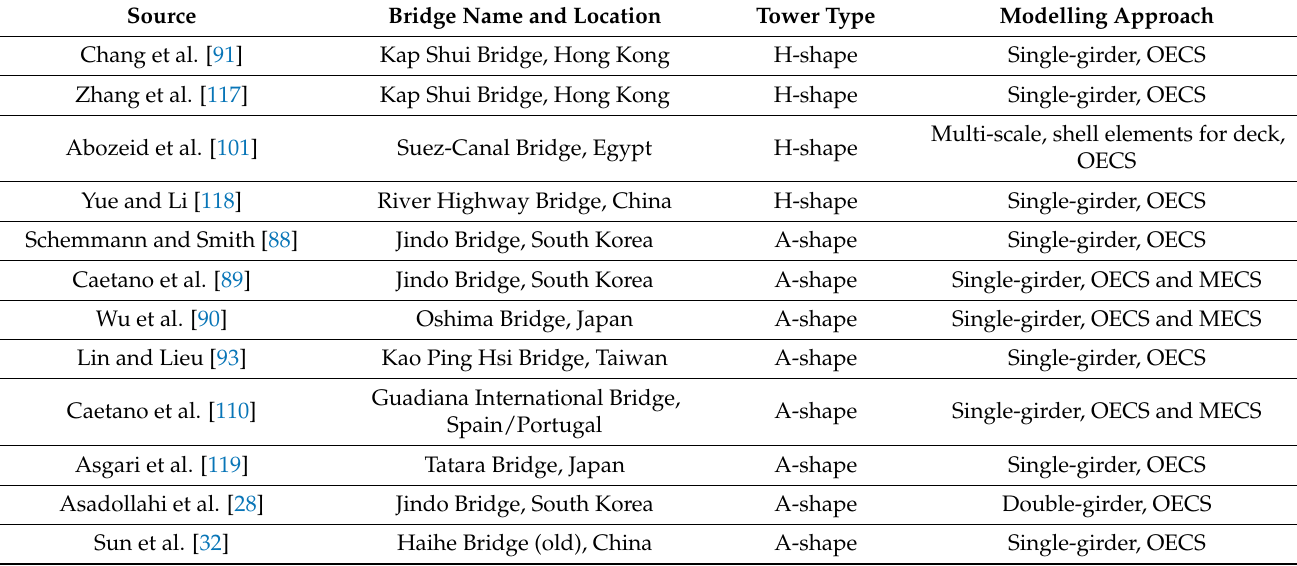
Table 3. FE modelling approaches for closed box section girders.